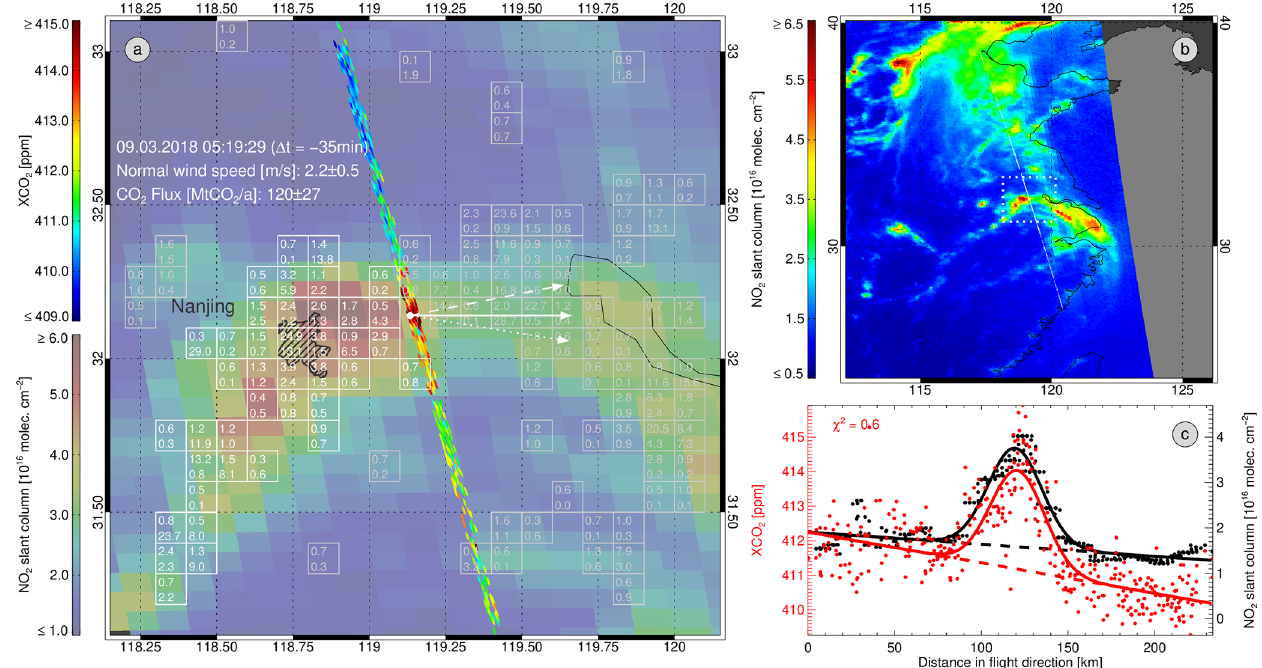
Figure 6. As in Fig. 1 but for Nanjing on 9 March